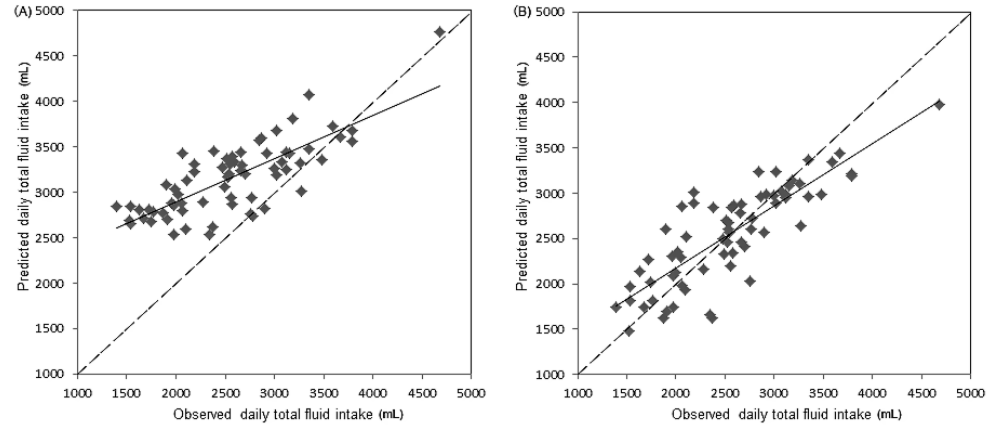
Figure 2. PLS model of the relationship between daily total fluid intake and urine biomarkers. ( A ) PLS model of the relationship between daily total fluid intake and seven variables. The solid line represents the line of agreement, while the dashed line represents the line of best agreement. ( B ) PLS model of the relationship between daily total fluid intake and two variables—urine volume and osmolality. The solid line represents the line of agreement, while the dashed line represents the line of best agreement.